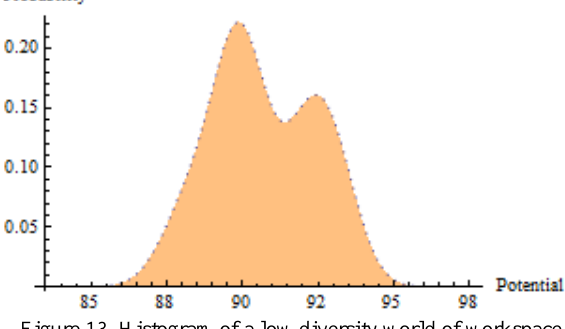
Figure 13. Histogram of a low diversity world of workspace. The relative mean deviation of the algorithm in case of a low diversity world was calculated by dividing the mean